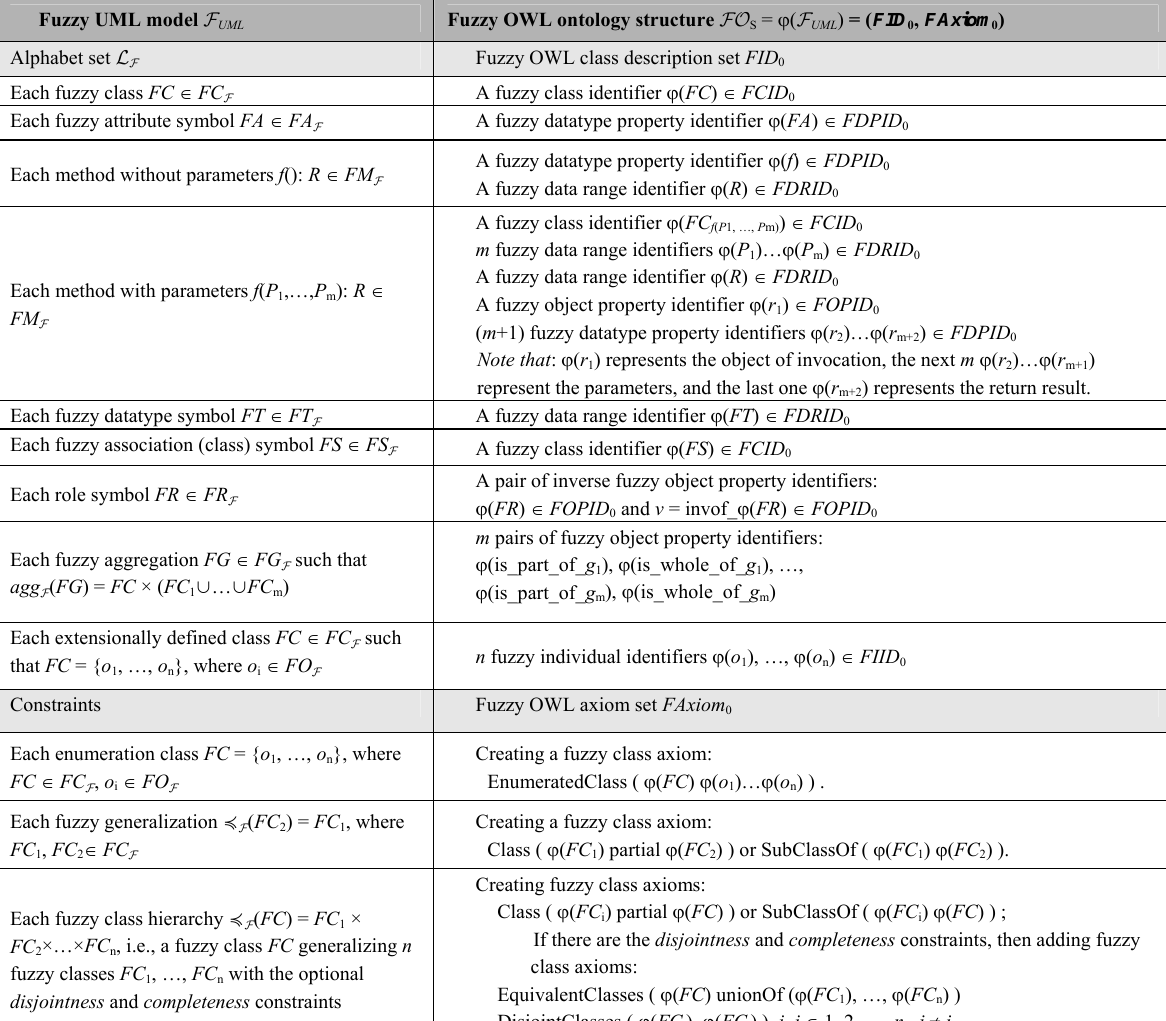
Table 2. Transforming rules from a fuzzy UML model to fuzzy OWL ontology